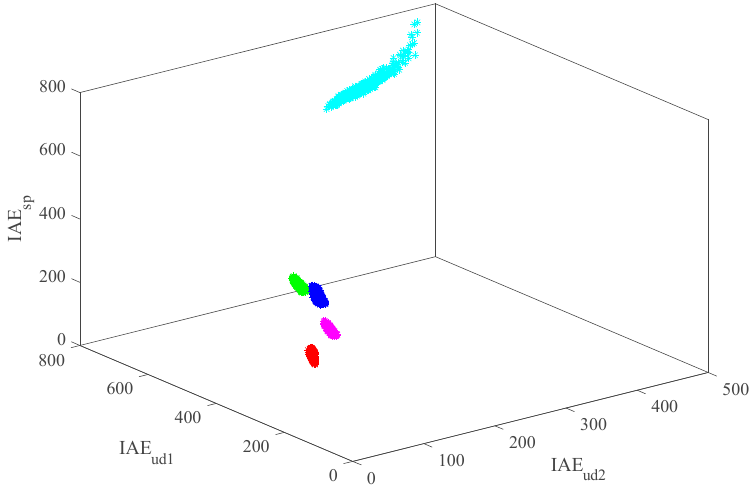
Figure 14. Records of IAE sp , IAE ud2 and IAE ud1 for the perturbed system. (OPI-PI: *, IPI-PI: *, ADRC-PI: *, MADRC-PI: *, Hybrid ADRC: *).